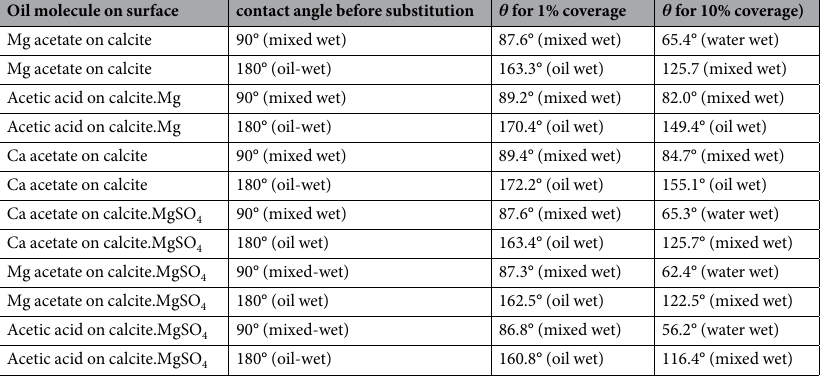
Table 2. Change in contact angle due to additive ions of sea water in oil wells for idealistic case of 1% and 10% of wettability